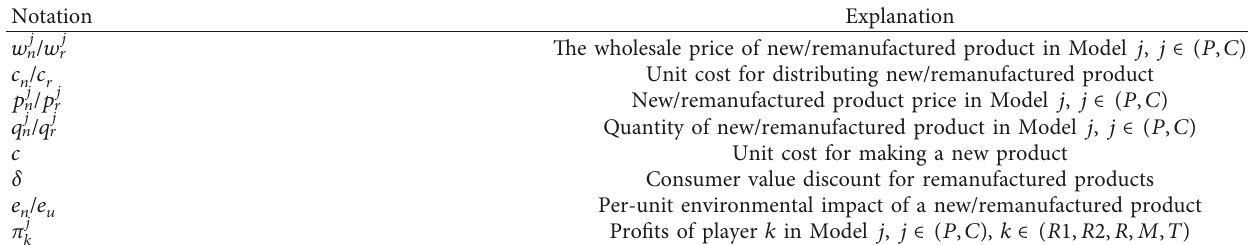
Table 1: Detailed notations and